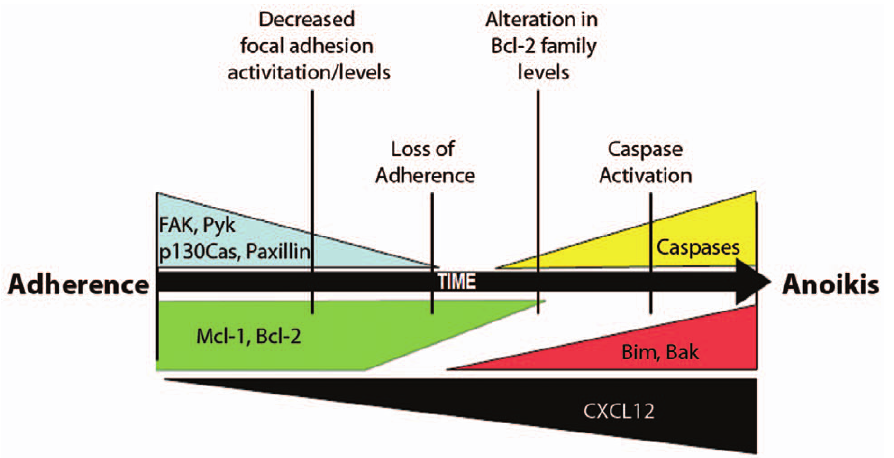
Figure 9. Schematic model of CXCL12-mediated anoikis in colorectal carcinoma cells. Cell culture in the presence of increasing levels of secreted CXCL12 in autologously expressing colon carcinoma cell lines reveals a temporal loss of focal adhesion proteins and increased Bim expression leading to increased anoikis and decreased metastatic potential. Initially, adherent cells expressing CXCL12 maintain expression and activation of focal adhesion proteins (FAK, Pyk, p130Cas, and paxillin) along with high levels of pro-survival Bcl-2 family members (Mcl-1 and Bcl-2). Prolonged production of CXCL12 leads to decreased focal adhesion activation and impaired cellular adhesion. Subsequently, levels of pro-survival Bcl-2 proteins decrease with the concomitant increase in pro-apoptotic Bim and Bak proteins. Changing the balance in Bcl-2 family protein expression toward increased pro-apoptotic protein levels results in caspase activation and execution of anoikis. Wedges indicate relative protein levels plotted over